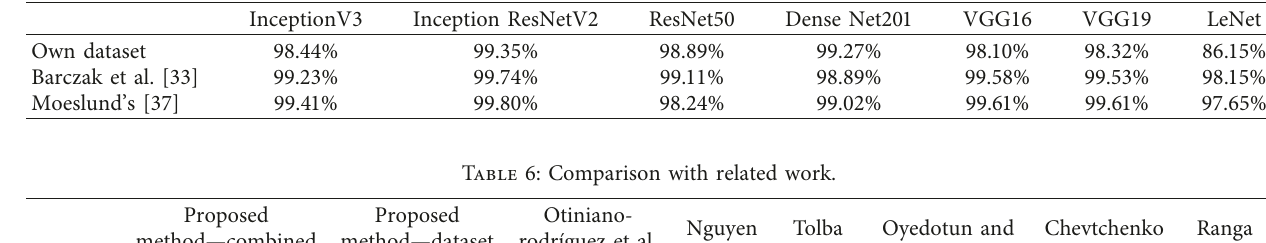
Table 5: Results obtained for each dataset individually using the architectures available in the literature.